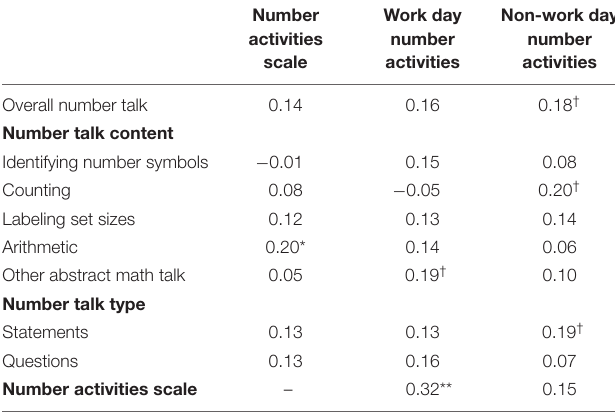
TABLE 10 | Associations among number talk content from the semi-structured observations, home number activities scale, and number activities reported on work and non-work days from the time diary interview.